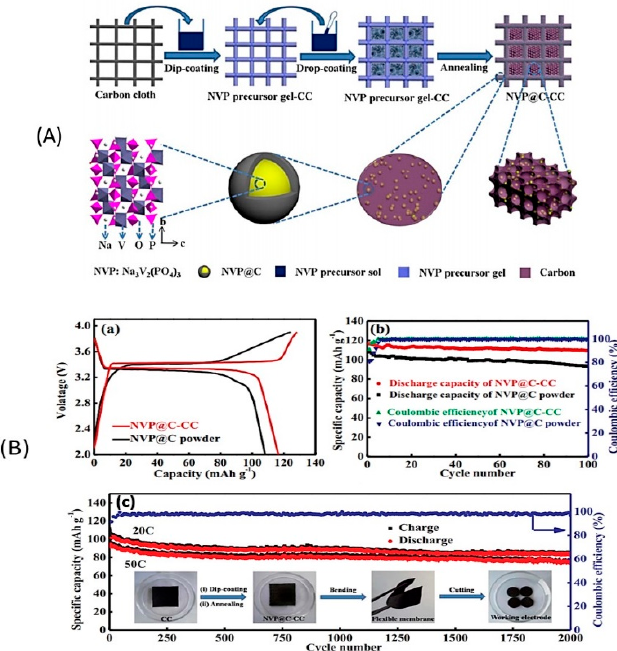
Figure 4. ( A ) Illustration of the preparation process of binder-free NVP@C-CC membrane,